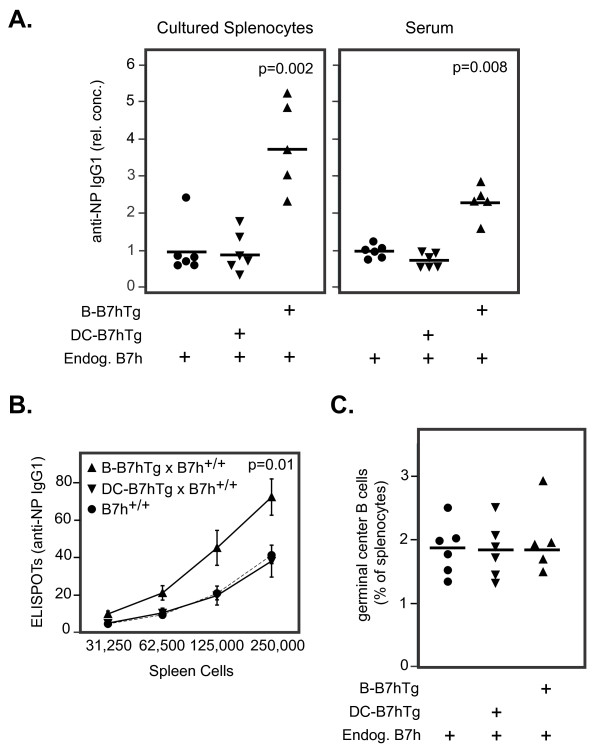
The level of B7h on plasma B cells regulates the number of antibody secreting cells generated by immunization. Transgenic and control mice on the B7h+/+ background were immunized with NP-CGG and analyzed after 14 days. (A) The relative concentration of anti-NP IgG1 antibodies in supernatants from overnight splenocyte cultures and in serum were measured by ELISA. Each symbol represents one mouse and bars indicate the mean of each group. The data were normalized such that the mean of the control group had a value of 1. P values are shown where statistically significant differences were found between transgenic and control groups. (B) The number of anti-NP IgG1-secreting splenocytes was determined using an ELISPOT assay. Symbols represent the population mean at each dilution and error bars show the standard error of the mean for each group. Statistical significance was found between control mice (n = 6) and B-B7hTg mice (n = 5), but not DC-B7hTg mice (n = 6). (C) The number of B220+IgDneg-GL7+Fas+ germinal center B cells was determined by flow cytometry. Each symbol represents one mouse and bars indicate the mean of each group. The data are representative of at least 3 independent experiments.